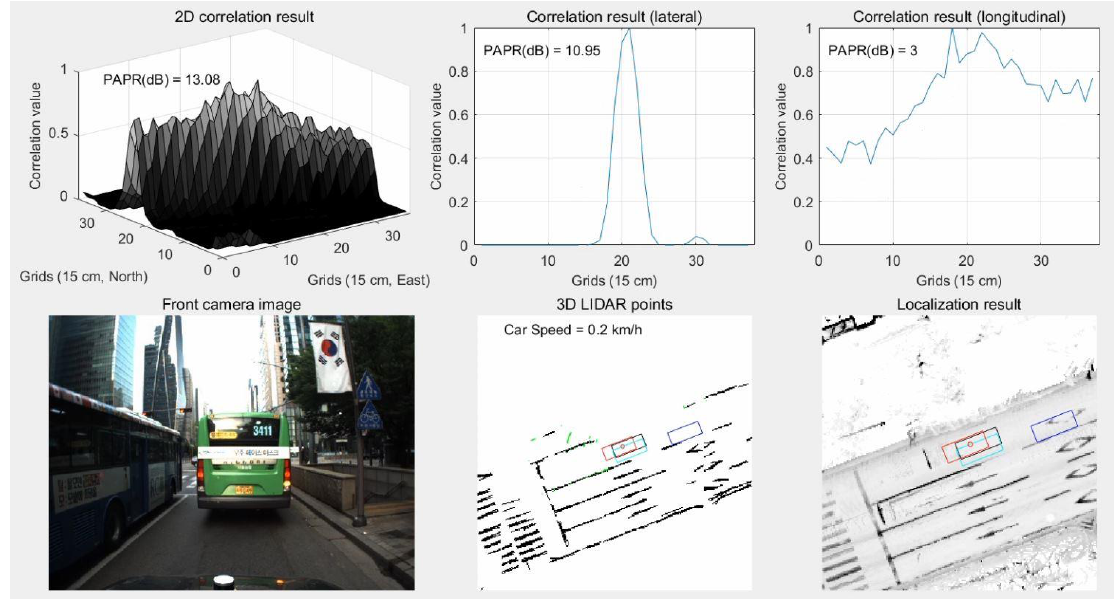
Figure 29. Results of localization using road marking in area with traffic congestion.